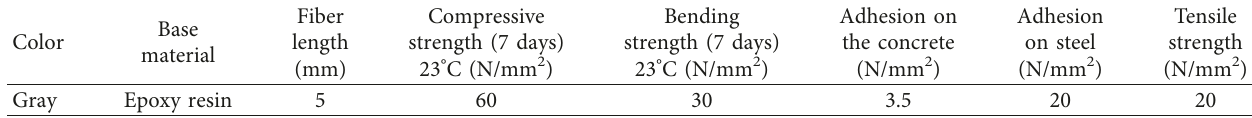
Table 2: The properties of carbon